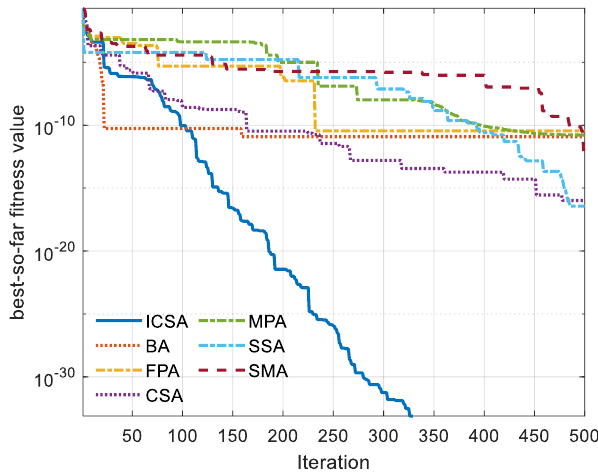
Figure 21. Convergence curve for F21.